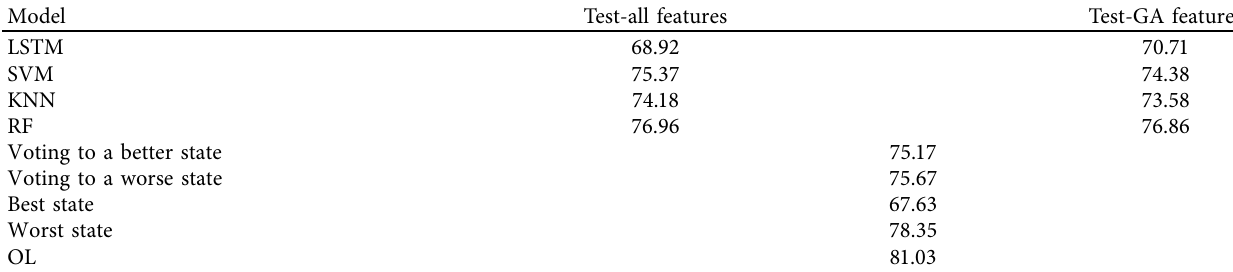
Table 6: Accuracy of predictions of ensemble and single models for test